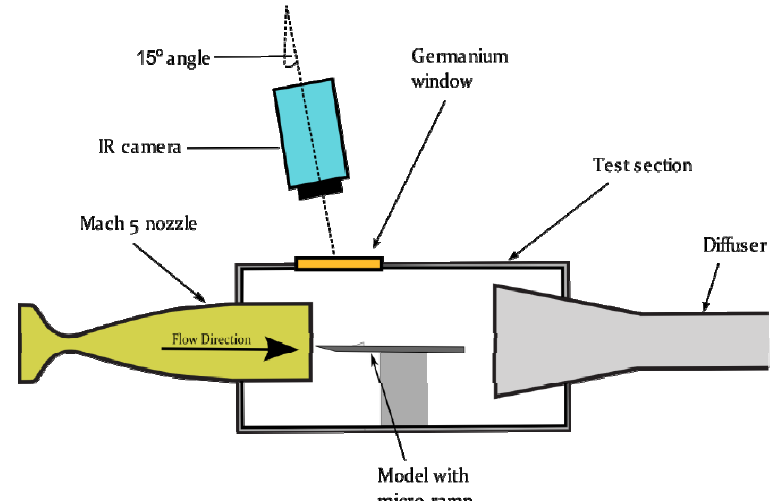
Figure 5. Experimental setup for infrared